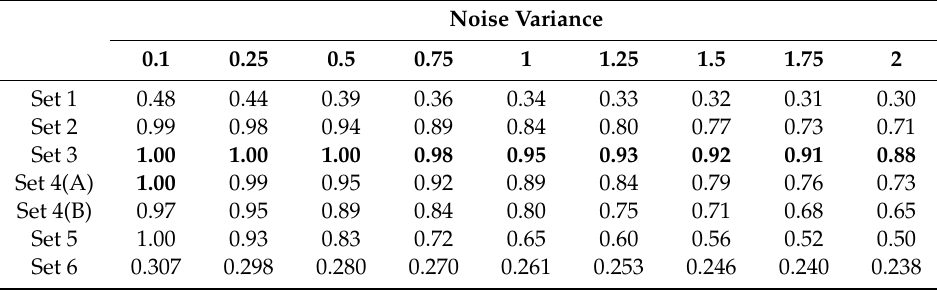
Table 1. Classification probabilities for the six sets of experiments involving ambiguous letters.